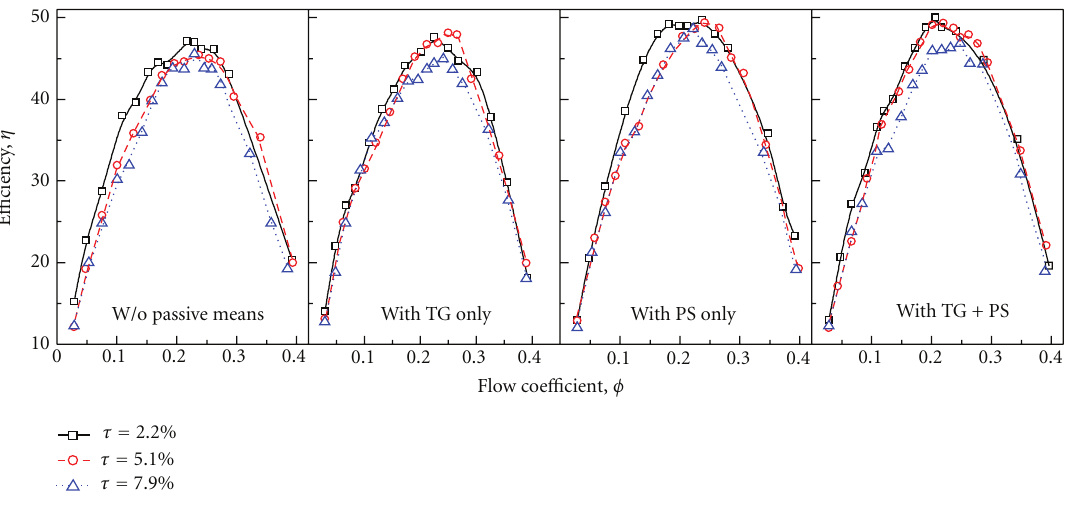
Figure 6: Performance characteristics of the centrifugal compressor ( η versus φ ): e ff ect of tip